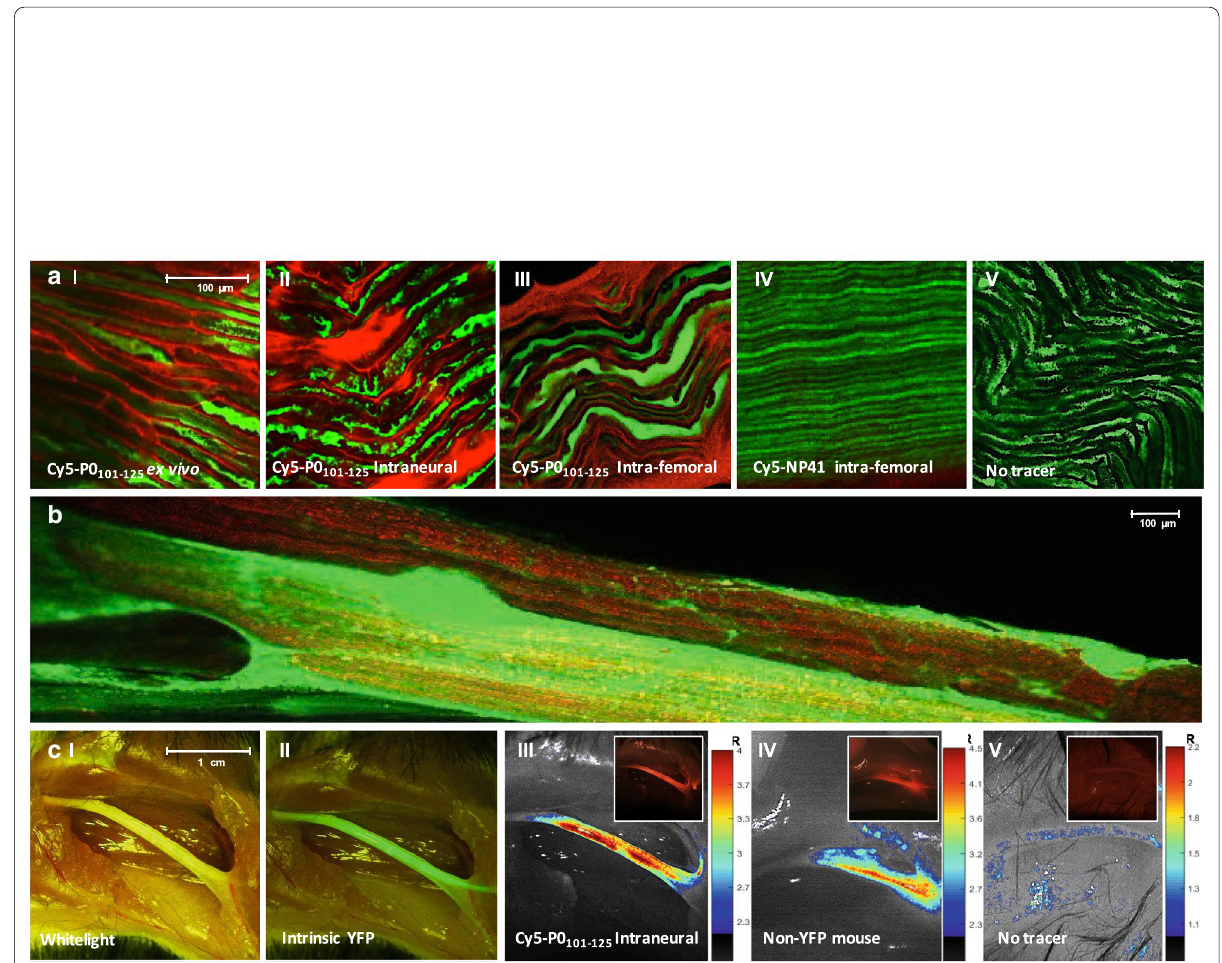
Fig. 4 Ex vivo and in vivo imaging of the nervus ischiadicus of mice. A 63 magnification of the nervus ischiadicus after (I) ex vivo incubation, × (II) intraneural administration or (III) intravenous (v. femoralis) administration of Cy5-P0 101–125 . (IV) Fluorescence confocal image of the nervus ischiadicus F after intravenous (v. femoralis) administration of Cy5-NP41 or (V) when no tracer was applied. B In vivo fluorescence confocal image of a large field of view of the nervus ischiadicus of a THY-1 YFP at 1 h after intravenous (v. femoralis) administration of Cy5-P0 101–125 . Cy5 in red and intrinsic YFP located in the axons of THY-1 YFP mice in green. C In vivo Dinolight microscopy images showing (I) a whitelight image of the nervus ischiadicus and (II) the intrinsic YFP signal in a THY-1 YFP mouse. Image processing after illumination of the nervus ischiadicus after